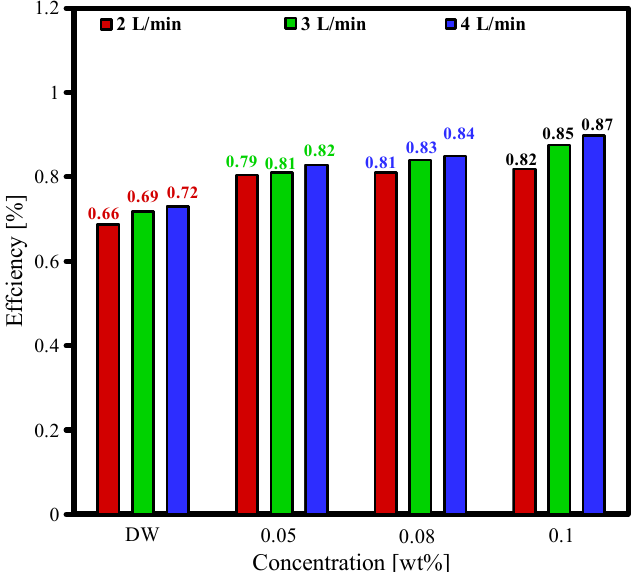
Figure 19. Effect of weight concentrations and flow rates on collector efficiency.